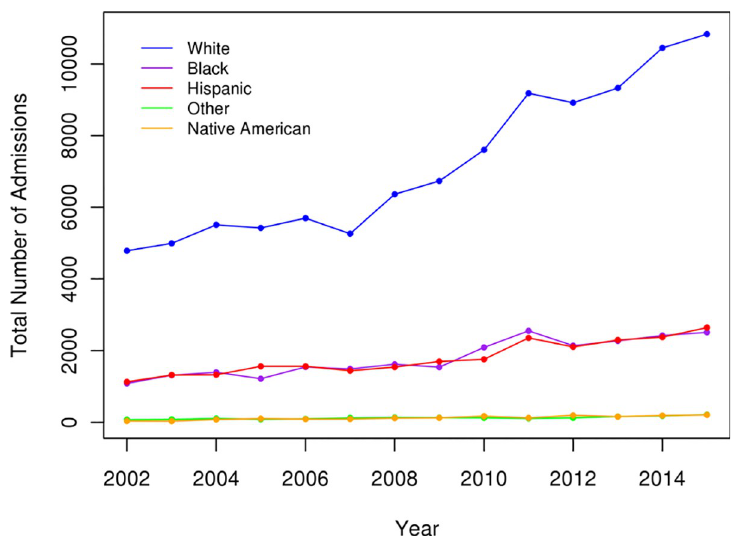
Fig 1. Inpatient admissions for diabetic foot infections.